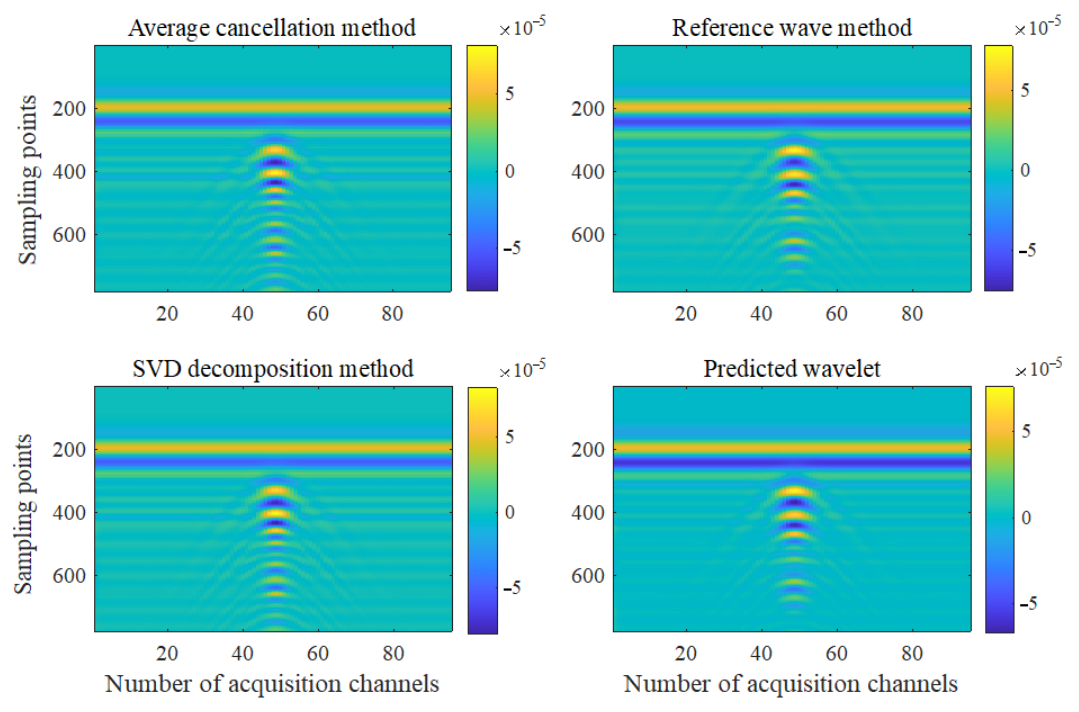
Figure 9. Comparison of deconvolution processing.